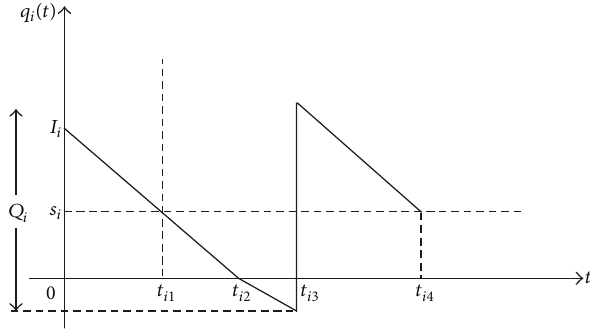
Figure 4: Inventory level of product 𝑖 at time 𝑡